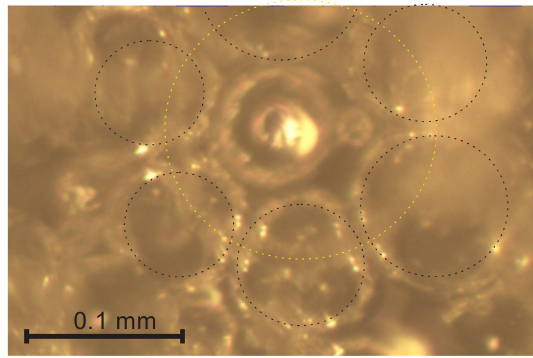
Figure 7. A bubble cut below the equatorial plane.